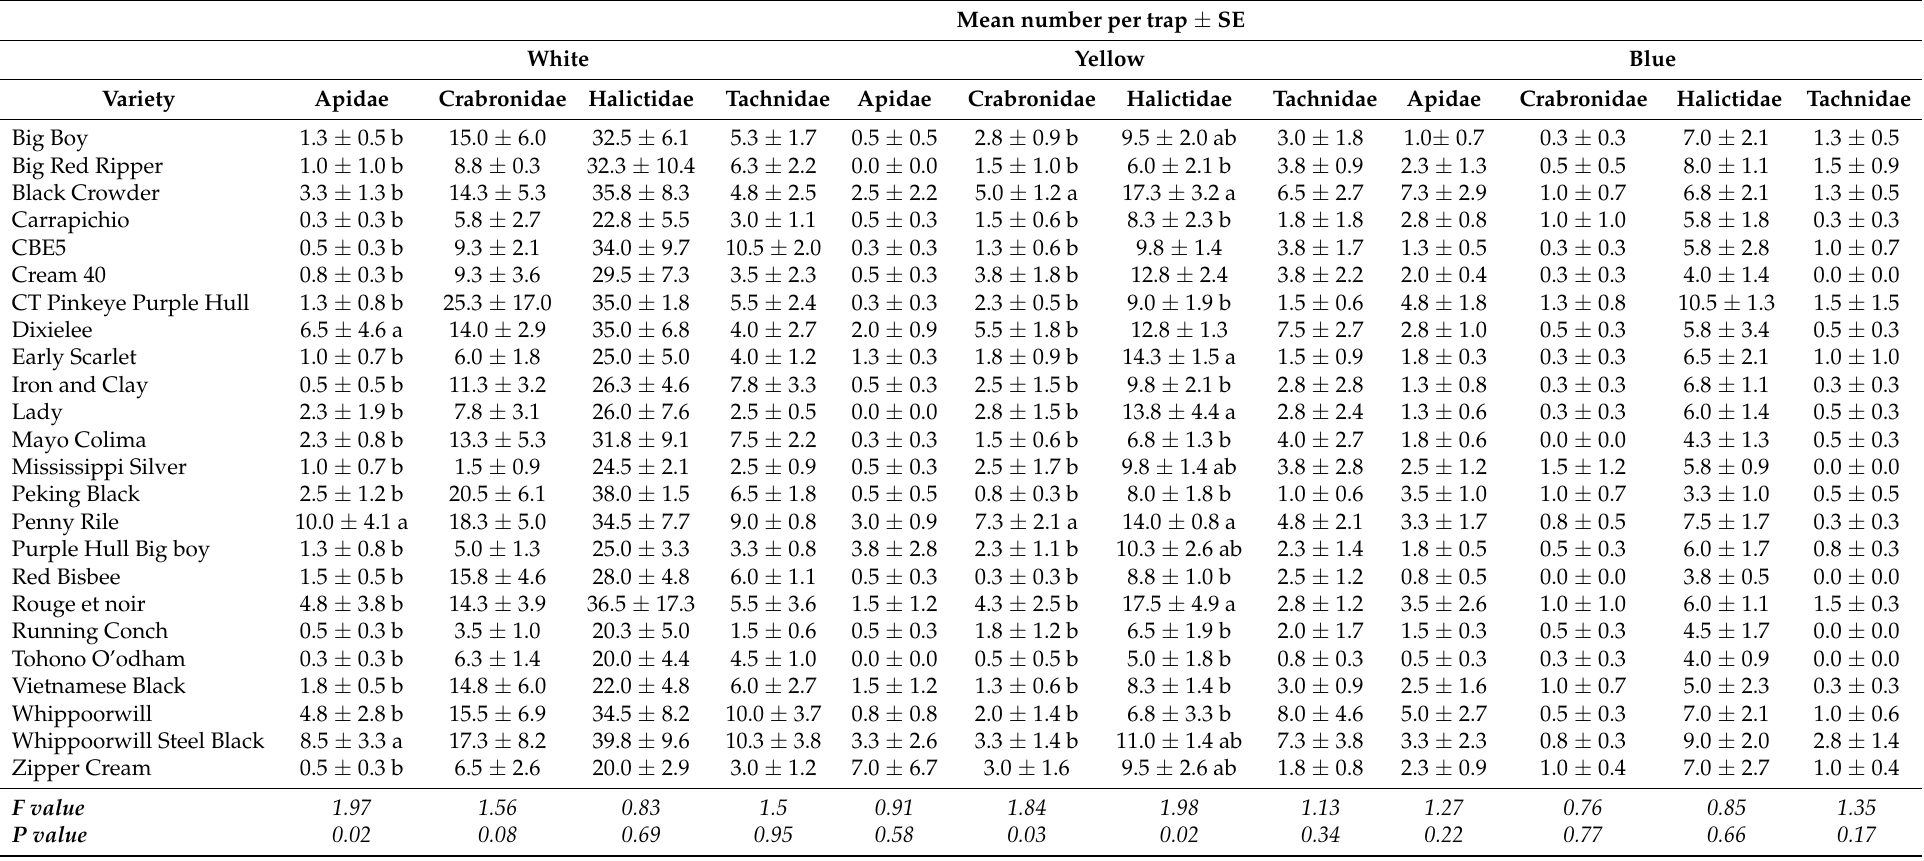
Table 3. Diversity and abundance (mean ± SE) of pollinators per pan traps on cowpea varieties over a five-week sampling period. Means numbers followed by the same letters within rows are not significantly different ( p >